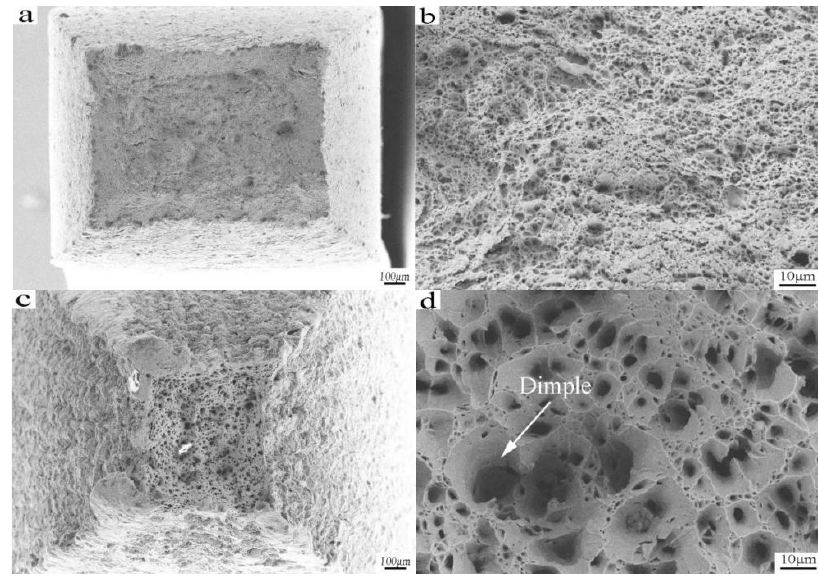
Figure 7. Tensile fracture morphology at room temperature and at a temperature of 850 °C and a strain rate of 1 × 10 − 4 s − 1 : ( a , b ) Tensile specimens at room temperature; ( c , d ) Tensile specimens at 850 °C.